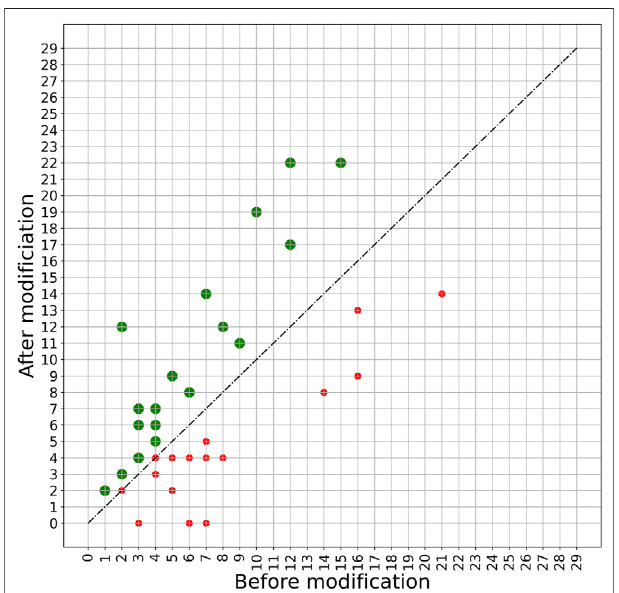
FIGURE 8 | Impact of applying model A with a 1000-nucleotide seed on phage sequences. The model is trained based on the genome sequence of phage 5294 with a seed length of 1000. The trained model is then used to modify the genome sequence of all 42 phages under study. The plot shows the host range of these phages before and after modi fi cation. The green spots show phages whose host range is improved after modi fi cation. The host ranges of 22 phages are improved after modifying with this model.